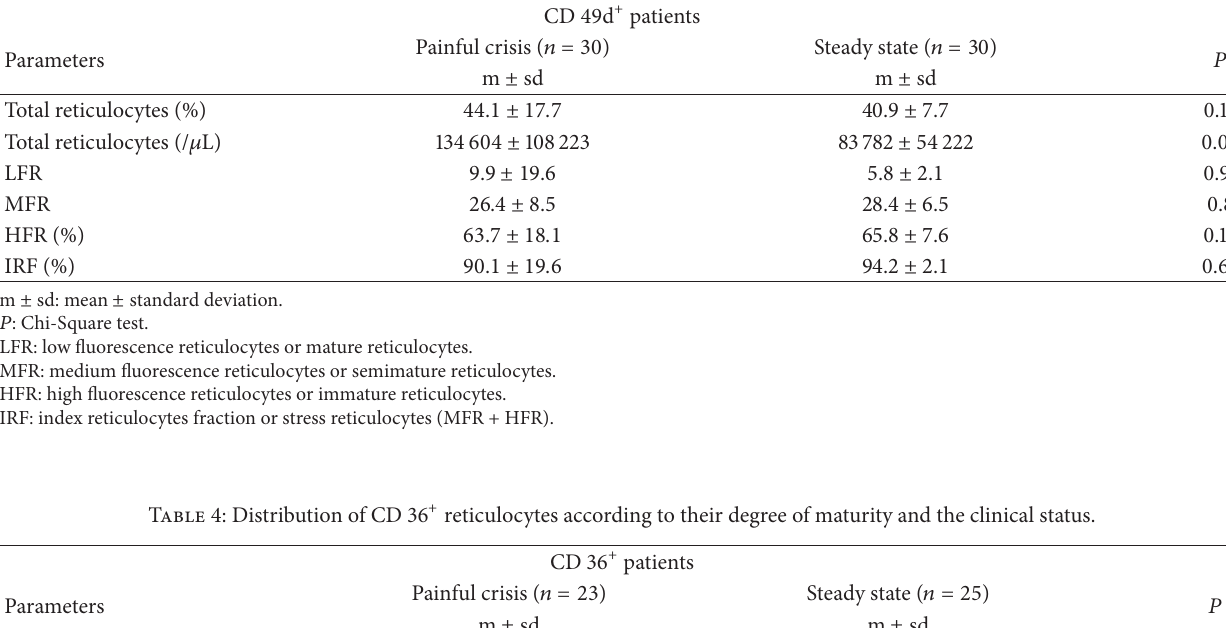
Table 3: Profile of CD 49d + reticulocytes according to their degree of maturity and the clinical status.